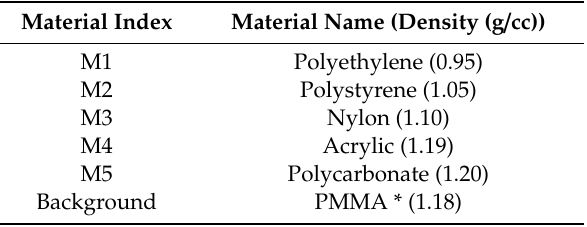
Table 3. Material index and name of each cylinder embedded in the American Association of Physicists in Medicine (AAPM)